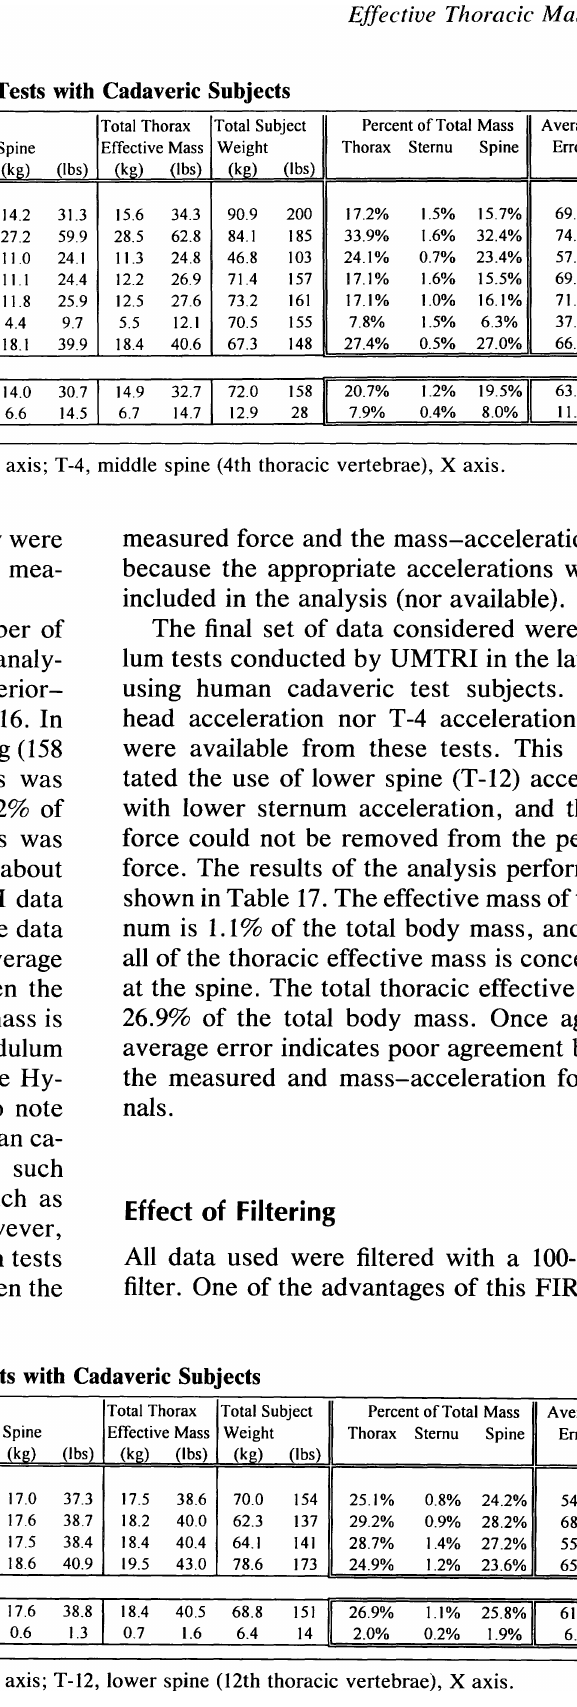
Table 16. CALSP AN Frontal Pendulum Tests with Cadaveric Subjects Test Test Signals Type